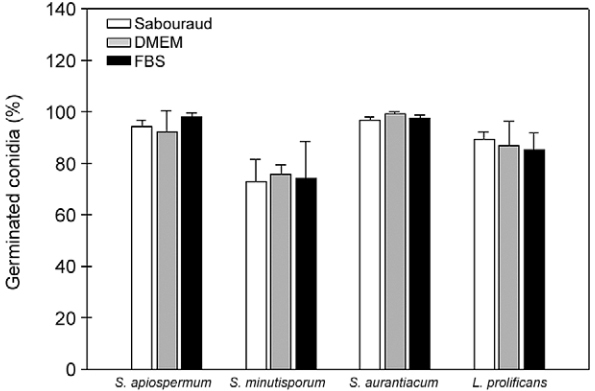
: evaluation of conidial germination of Scedosporium apiospermum, S. minutisporum, S. aurantiacum and Lomentospora prolificans in different culture media. Conidial cells were incubated for 4 h in Sabouraud, Dulbecco’s modified Eagle’s medium (DMEM) or fetal bovine serum (FBS) at 37ºC with an atmosphere of 5% CO2. After incubation, fungal cells were counted by using an inverted microscope. The results are shown as the mean ± standard deviation of three independent experiments. There was no statistical difference in the germination of each fungal species when cultured under these different culture media.